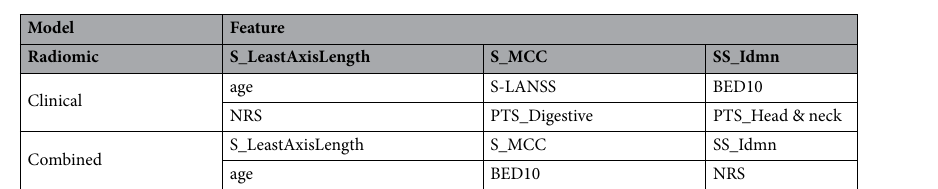
Table 2 . The model features after feature selection. S_LeastAxisLength LeastAxisLength from an ROI of spine, S_MCC MCC from an ROI of spine, SS_Idmn Idmn from an ROI of spine and surrounding tissues, PTS_ Digestive primary tumor site is digestive, PTS_Head & neck primary tumor site is Head &